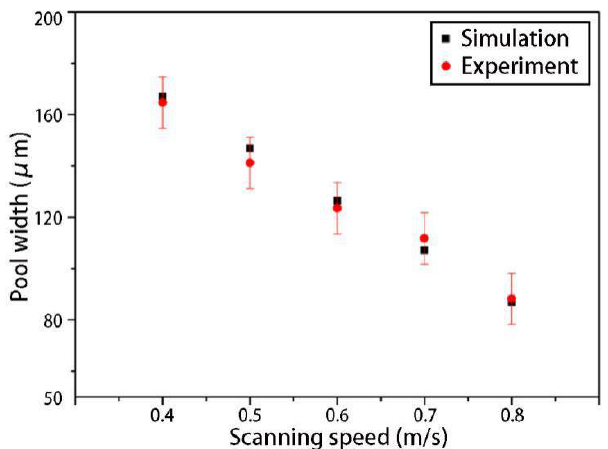
Figure 18. Comparison of simulation and experimental [35] solidified track widths under different scanning speeds.